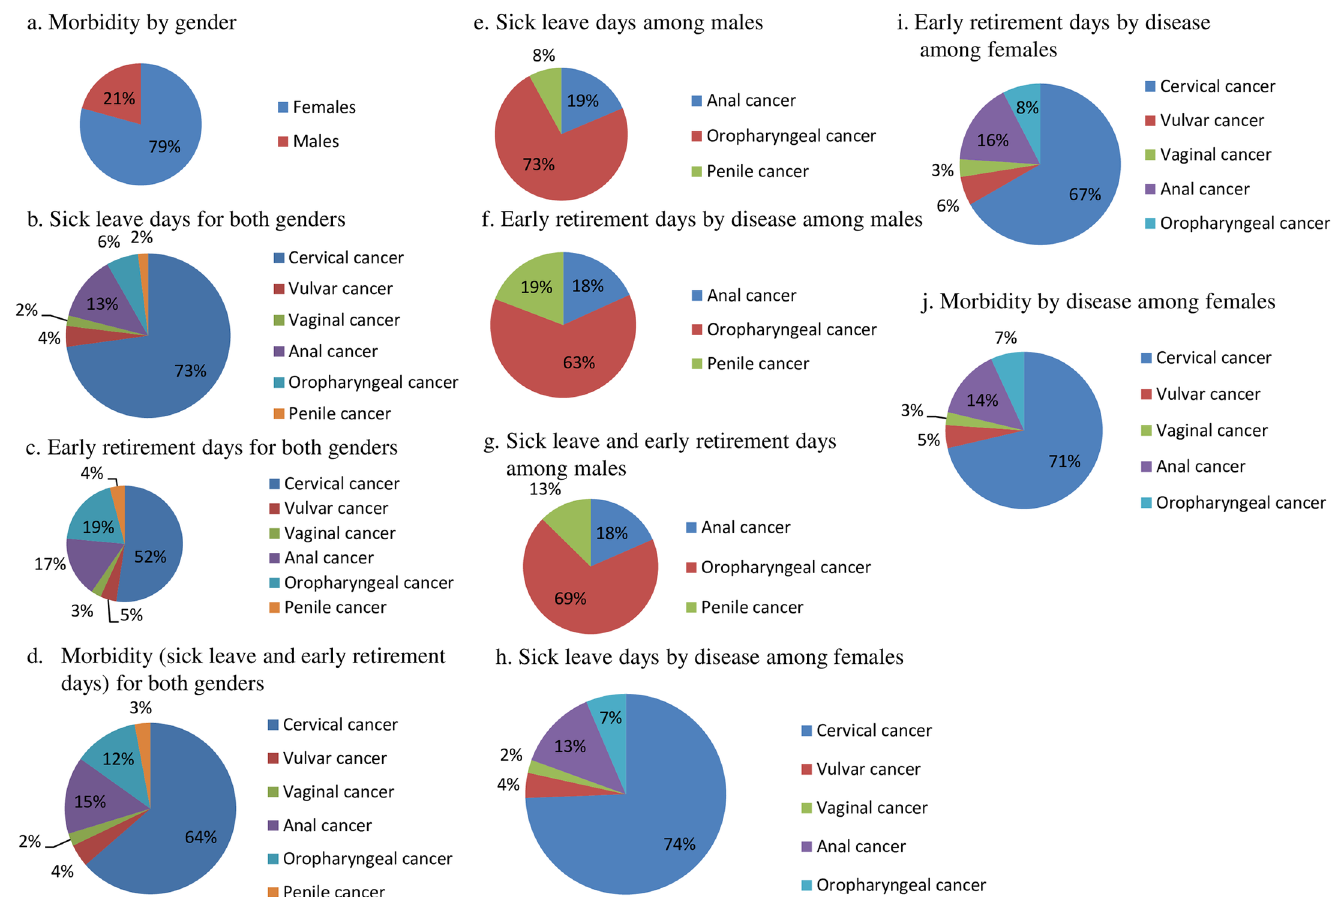
Fig 2. HR HPV-attributable fraction of morbidity (i.e., sick leave and early retirement days) by HPV-related disease and gender. (a) Morbidity by gender. (b) Sick leave days for both genders.(c) Early retirement days for both genders.(d) Morbidity (sick leave and early retirement days) for both genders. (e) Sick leave days amongmales. (f) Early retirement days by diseaseamongmales. (g) Sick leave and early retirement days among males. (h) Sick leave days by diseaseamongfemales. (i) Early retirement days by diseaseamongfemales. (j) Morbidity by disease amongfemales.